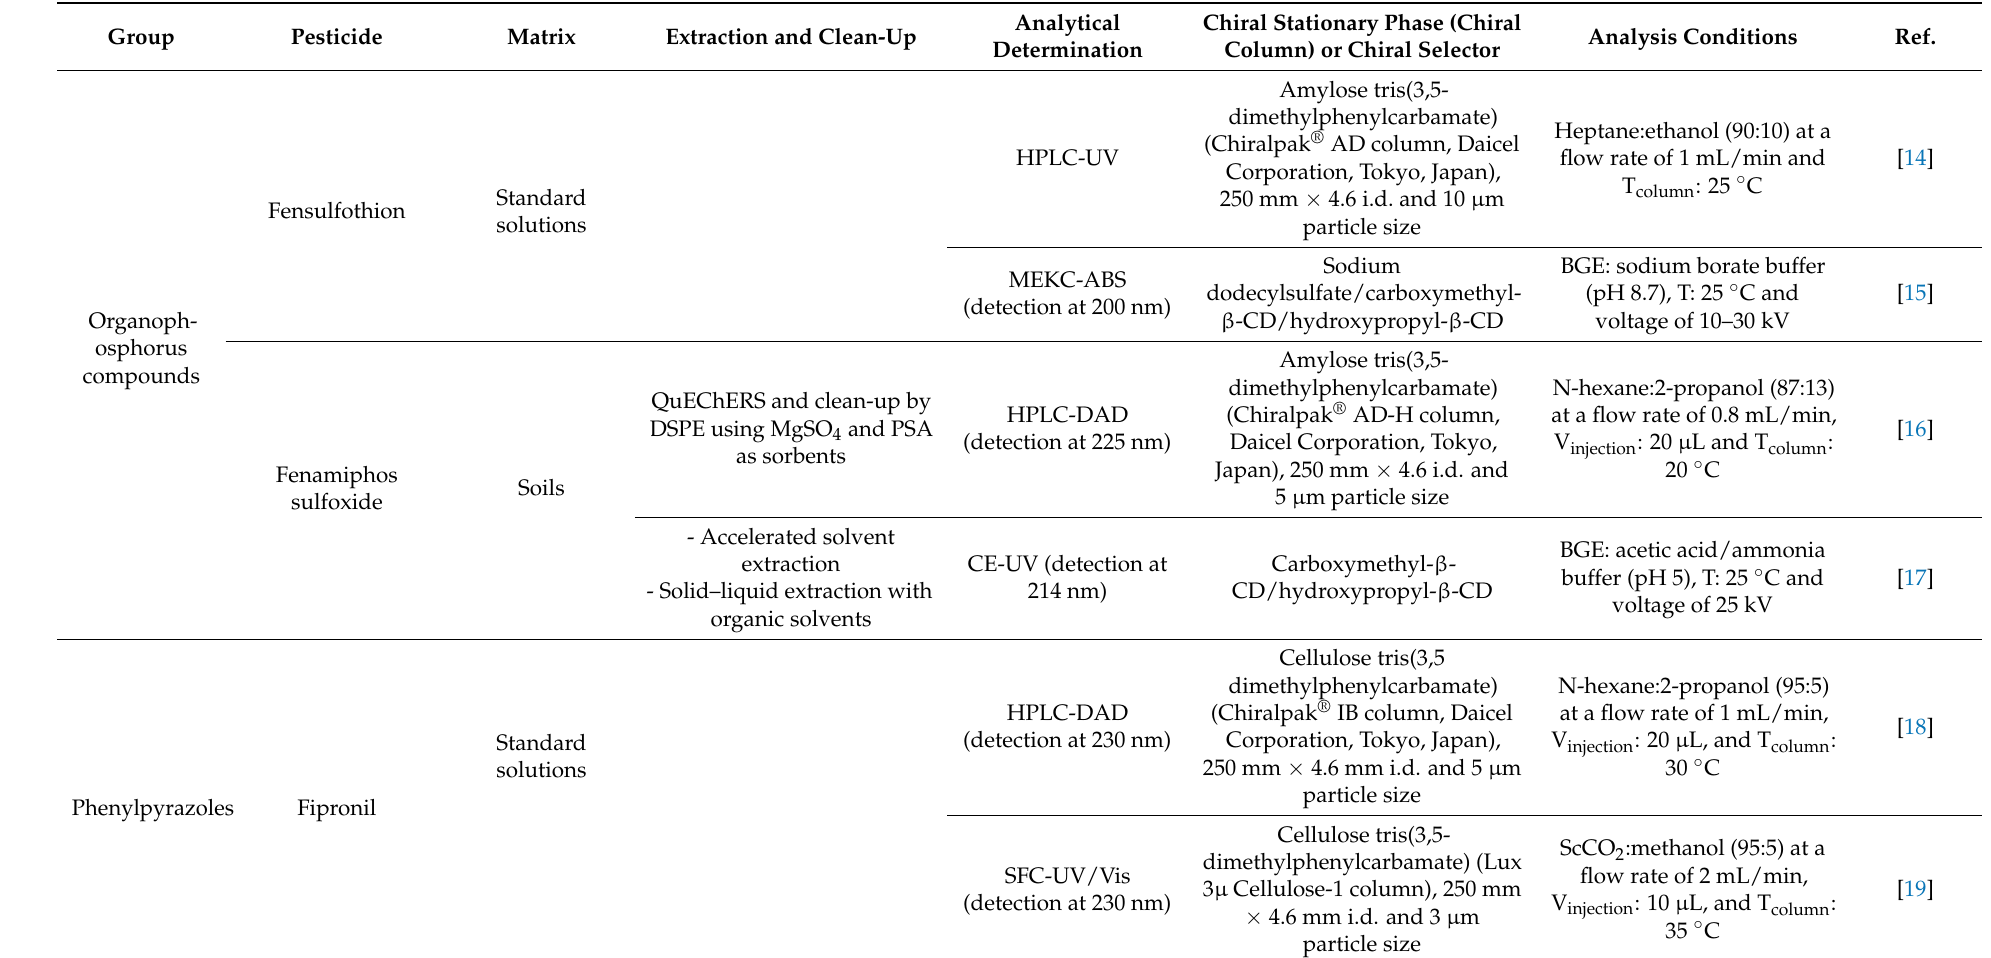
Table 1. Extraction and analytical techniques used in the chiral analysis of the pesticides described in this